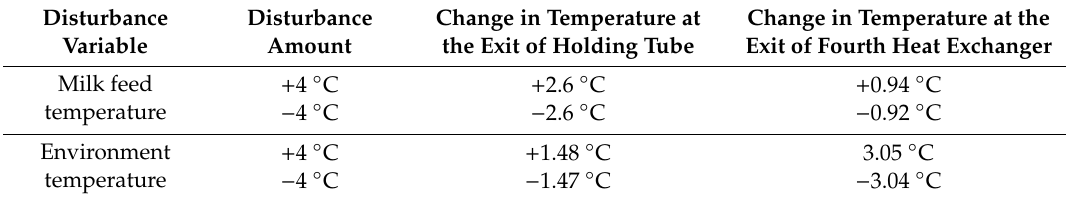
Table 2. E ff ects of input changes on steady-state conditions of the pasteurization